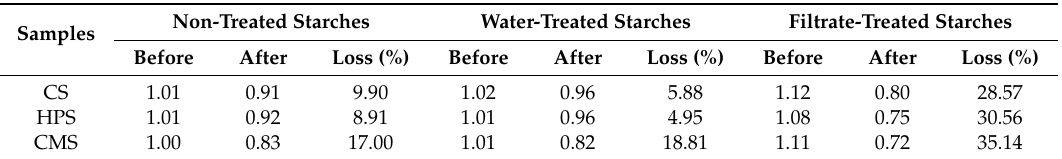
Table 3. The weight (g) of non-treated, water-treated and filtrate-treated starches before and after heated at 200 °C for 5 h, and the weight loss (%).